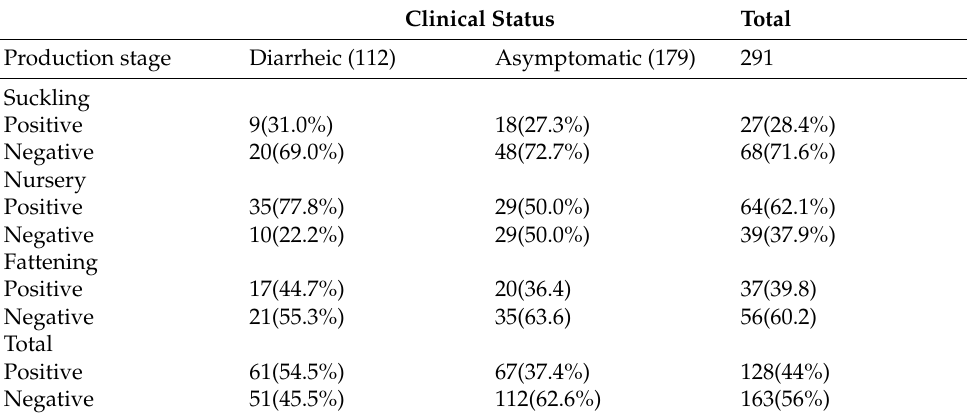
Table 4. Prevalence of PSV infection in diarrheic and asymptomatic